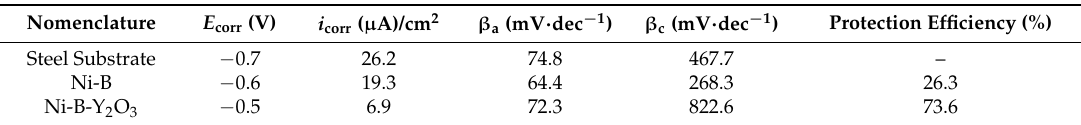
Table 3. Potentiodynamic polarization parameters of steel substrate, Ni-B and Ni-B-Y 2 O 3